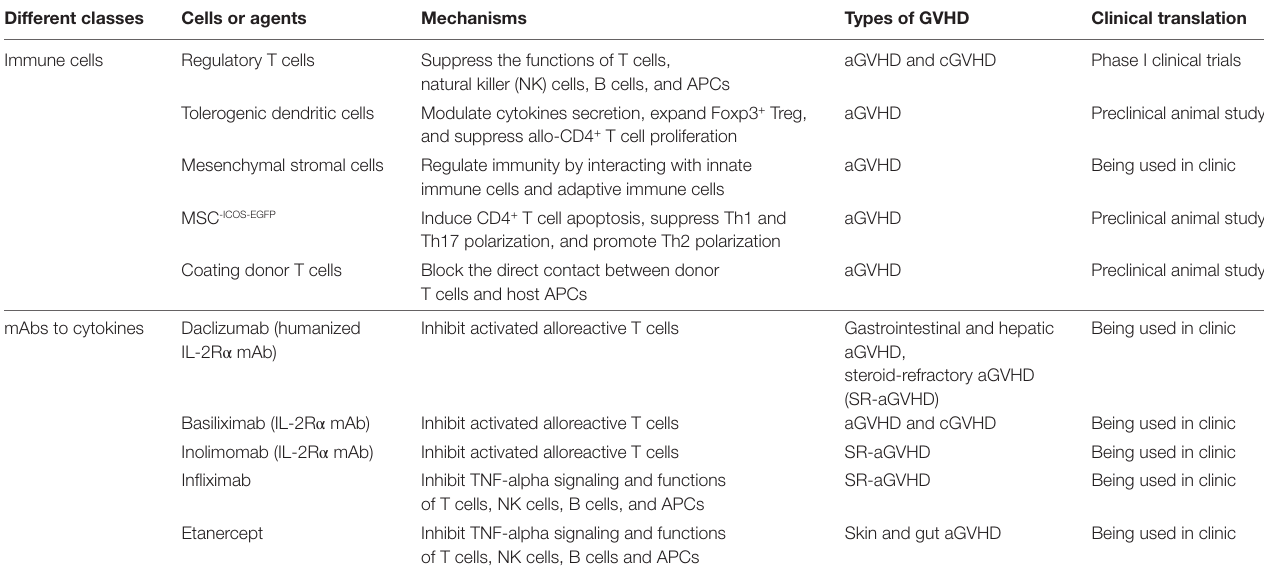
TAble 1 | Immune cells and monoclonal antibodies (mAbs) to cytokines for the treatment of graft-versus-host disease (GVHDs). Different classes Cells or agents Mechanisms Types of GvHD Clinical